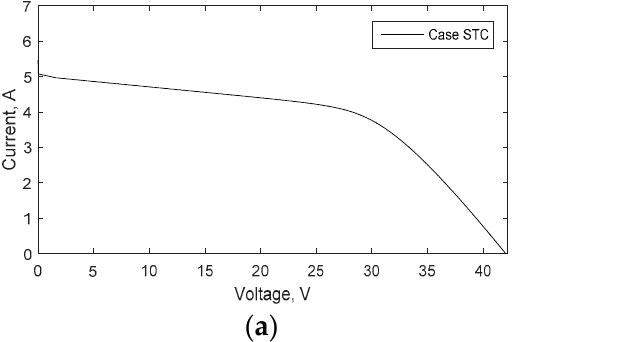
Figure 6. Characteristics of PV panel for pattern 1: ( a ) P-V, ( b ) I-V.